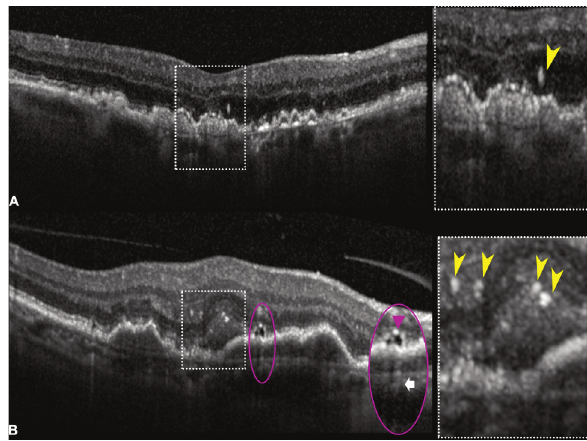
Figure 2: Spectral-domain optical coherence tomography (SD- OCT) B-scans illustrating hyperreflective foci (HRF) in age-related macular degeneration (AMD). (a) SD-OCT B-scan of intermediate AMD demonstrating a large HRF overlying confluent drusen lo- cated just above the external limiting membrane within the outer nuclear layer (inset, yellow arrowhead ). HRF may represent mi- grating retinal pigment epithelium cells or a nascent type 3 lesion. Nascent lesions can be differentiated from type 3 macular neo- vascularization for the absence of exudative changes, as intraretinal fluid and cystic changes on OCT B-scans. (b) SD-OCT B-scan showing a case of macular neovascularization with multiple HRF located in the subretinal space and outer plexiform layer (inset, yellow arrowheads ), probably of microglial origin, and more in- terestingly associated with a subretinal lipid globule. This novel OCT feature appears as a roundish hyporeflective structure (inset, purple ellipse ) with a characteristic hypertransmission tail ( white arrow ), which is originated from a lensing effect produced by a lipidic content